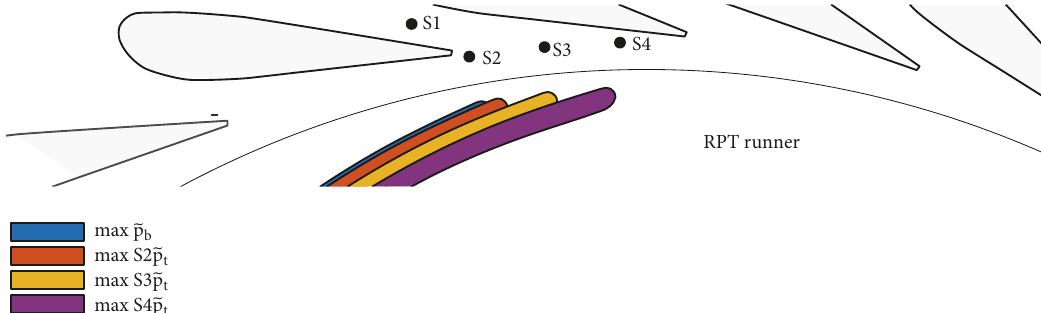
Figure 10: The blade positions for the RPT where the highest effect was found from throttling and the measured total pressure in the location S2-S4.